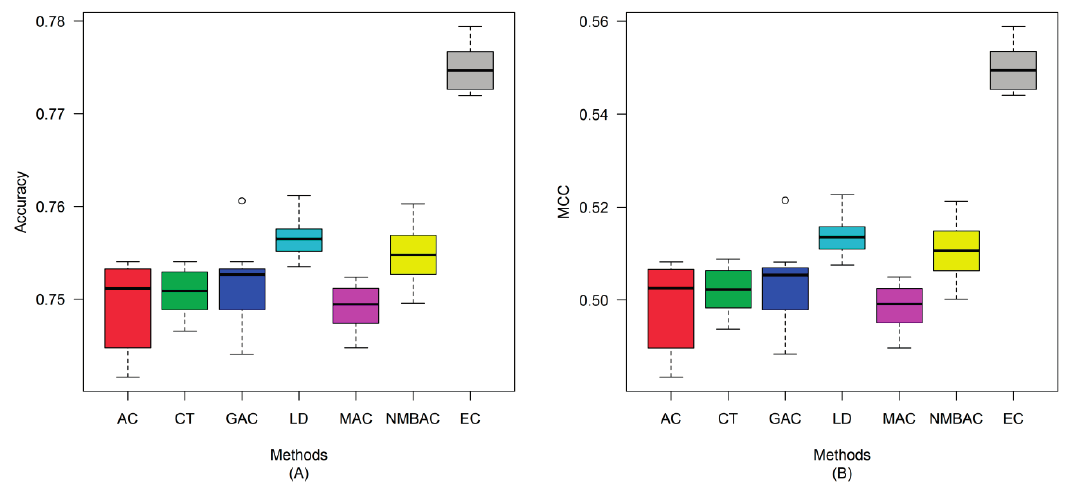
Figure 10. Average accuracy and MCC of different methods on the Silver Yeast dataset with five-fold cross-validation. ( A ) Accuracy; ( B ) MCC.